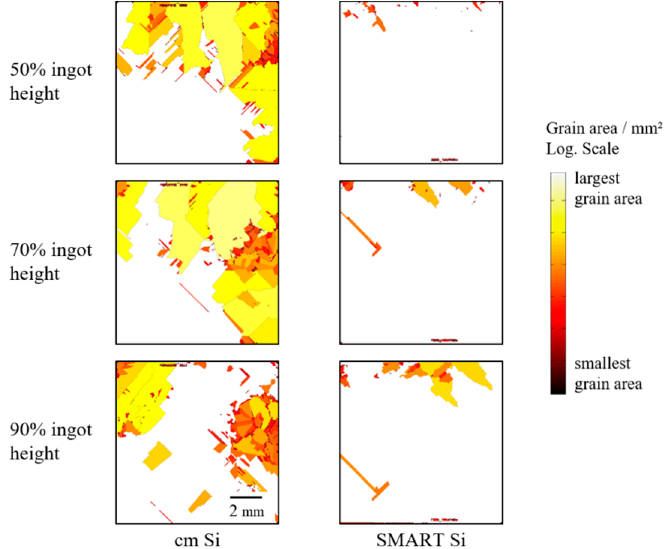
Figure 3. Segmented images of wafers from cm Si ( left ) and SMART Si ( right ) wafers from different ingot heights. Segmented grains are colored due to their area size (white: largest grain, logarithmic color scale). Table 1. Monocrystalline area share at different ingot heights for the cm Si and SMART Si materi- als.